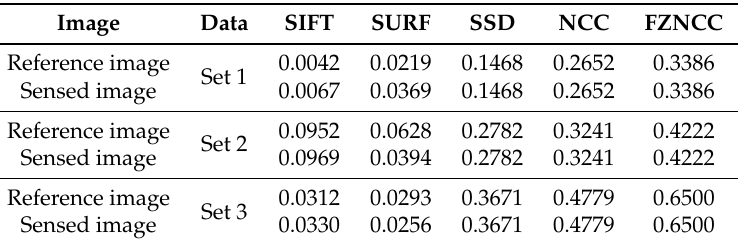
Table 2. CPR comparison.